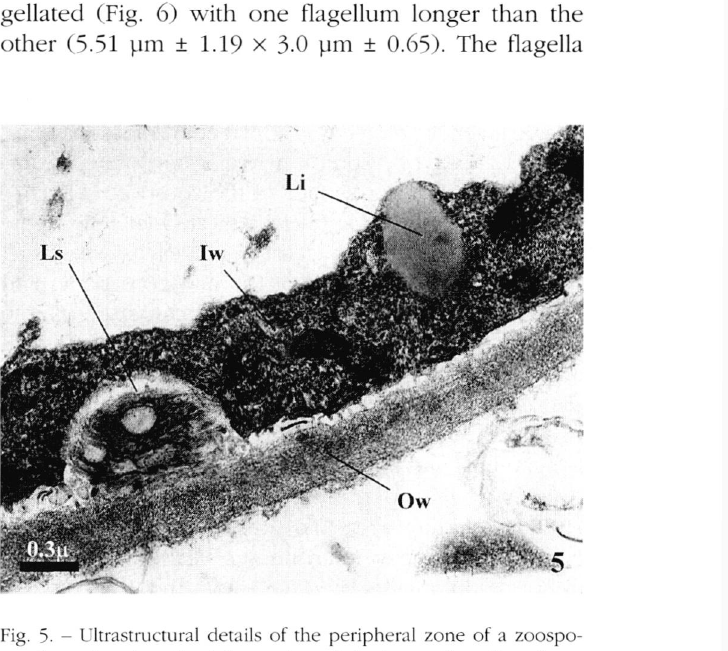
spores (Fig. 6). Zoospore body length ranged from 2.2 to 4.7 um (mean = 3.73 ± 0.48) and the width from 1.4 to 2.5 pm (mean = 2.41 ± 0.36). Zoospores were bifla­ gellated (Fig. 6) with one flagellum longer than the